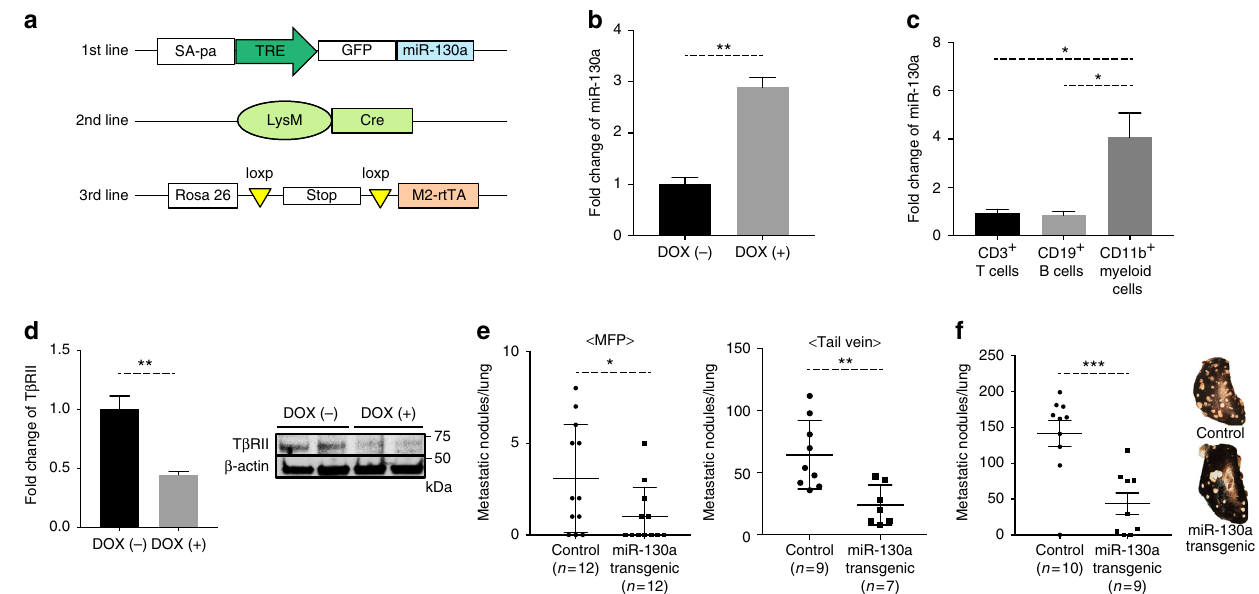
Fig. 3 miR-130a transgenic mice showed a decreased metastasis. a GEM strains crossbred to produce a myeloid-speci fi c Tet-inducible miR-130a transgenic mouse. b Fold change of miR-130a in Gr-1 + CD11b + myeloid cells from miR-130a transgenic mice treated with doxycycline (DOX), which was quanti fi ed and normalized to that of untreated mice. c miR-130a expression in CD3 + T cells, CD19 + B cells, and Gr-1 + CD11b + myeloid cells from the splenocytes of the miR-130a transgenic mice treated with DOX ( n = 3). d Left panel: qRT-PCR of T β RII in Gr-1 + CD11b + myeloid cells from the spleen of E0771 tumor-bearing miR-130a transgenic mice with DOX treatment ( n = 3); right panel: Western blot of T β RII. e Number of E0771 metastatic nodules in miR-130a transgenic mice treated with DOX compared with control mice (Left panel: spontaneous metastasis, n = 12; Right panel: experimental metastasis, n = 7 – 9). f Metastasis nodule counts of Lewis lung carcinoma in miR-130a transgenic mice treated with DOX compared with control mice after tail vein injection.